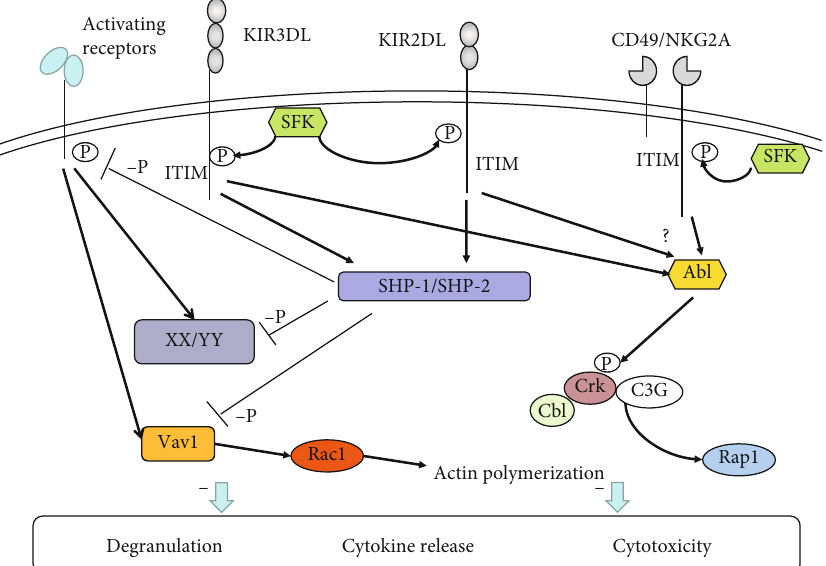
Figure 1: Signaling pathways of inhibitory receptors in NK cells. After KIR2DL, KIR3DL, and CD49/NKG2A bind to their corresponding ligands, the ITIM sequences are phosphorylated by Src-family kinase (SFK). Furthermore, the phosphorylated ITIM recruits SHP-1/SHP- 2, which downregulates the phosphorylation level of the downstream signaling molecules (XX/YY) of activating receptors, including Vav1, thereby inhibiting NK cell function. In addition, Crk binds to Abl and is phosphorylated by Abl, which separates Crk from the Cbl-Crk- C3G complex, further inhibiting NK cell